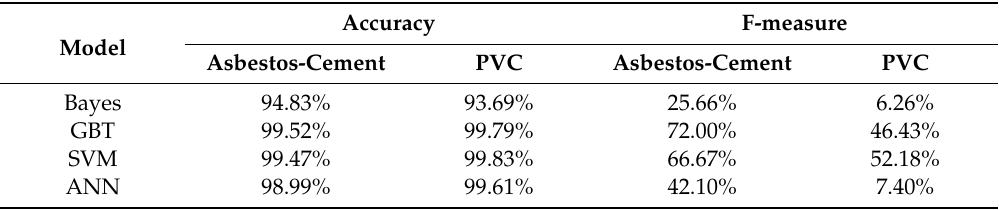
Table 6. Accuracy and the F-measure.